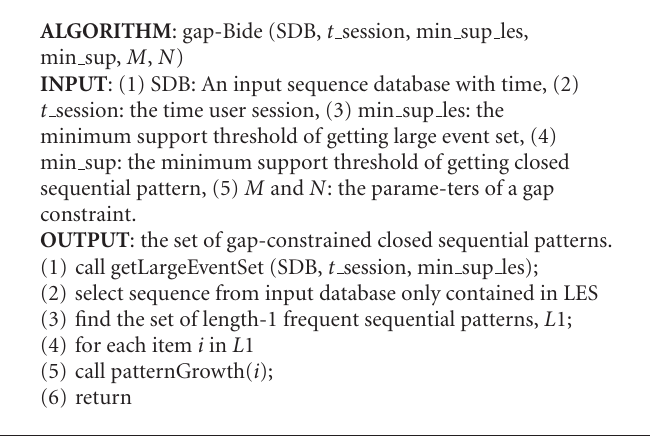
Algorithm 1: Improved Gap-BIDE